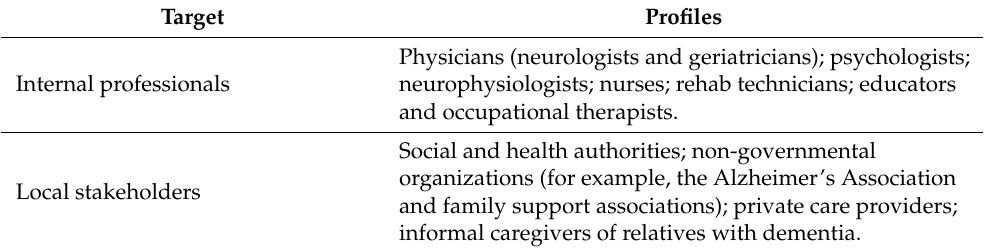
Table 1. Targets and profiles included in the